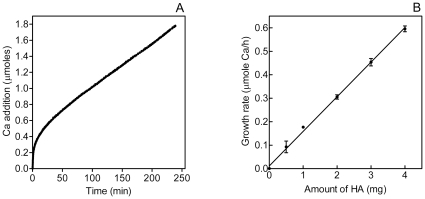
Constant-composition/seeded growth assay of HA formation.A. Typical titration curve obtained in the absence of effector. B. Relationship between rate of titrant addition and amount of seed crystal added. Equation of regression line is y = 0.147 x + 0.012 (r2 = 0.988, P < 0.001).